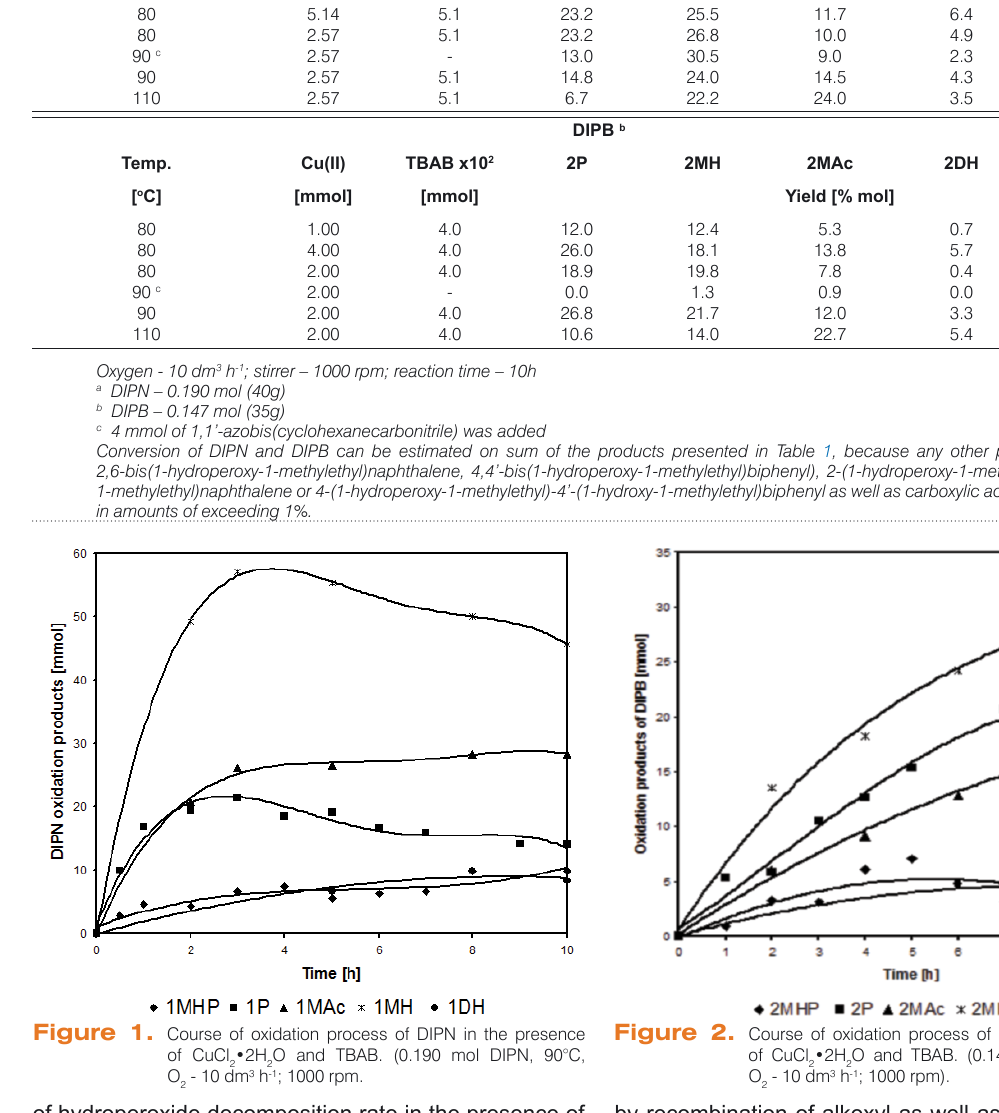
Figure 1. Course of oxidation process of DIPN in the presence